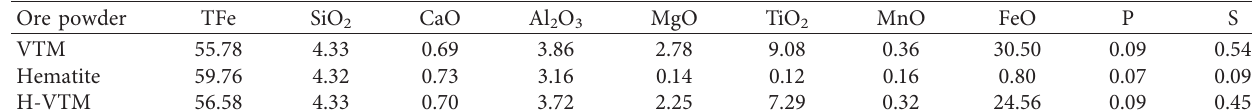
Table 1: Chemical composition of ore powder